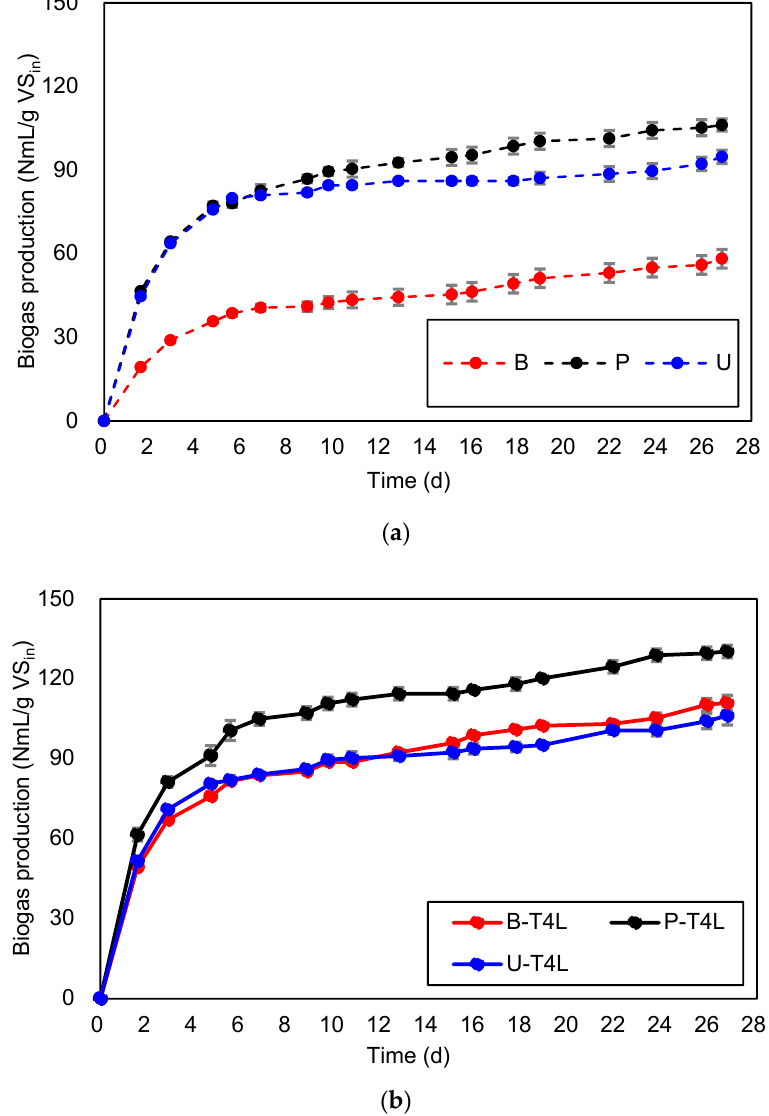
Figure 3. Accumulated biogas production in the BMP tests using (a) raw secondary sludges, and (b) sludges treated with the bacteriophage T4 lysozyme (B: Busan sample, P: Pohang sample, U: Ulsan sample; T4L: treated with the bacteriophage T4 lysozyme).